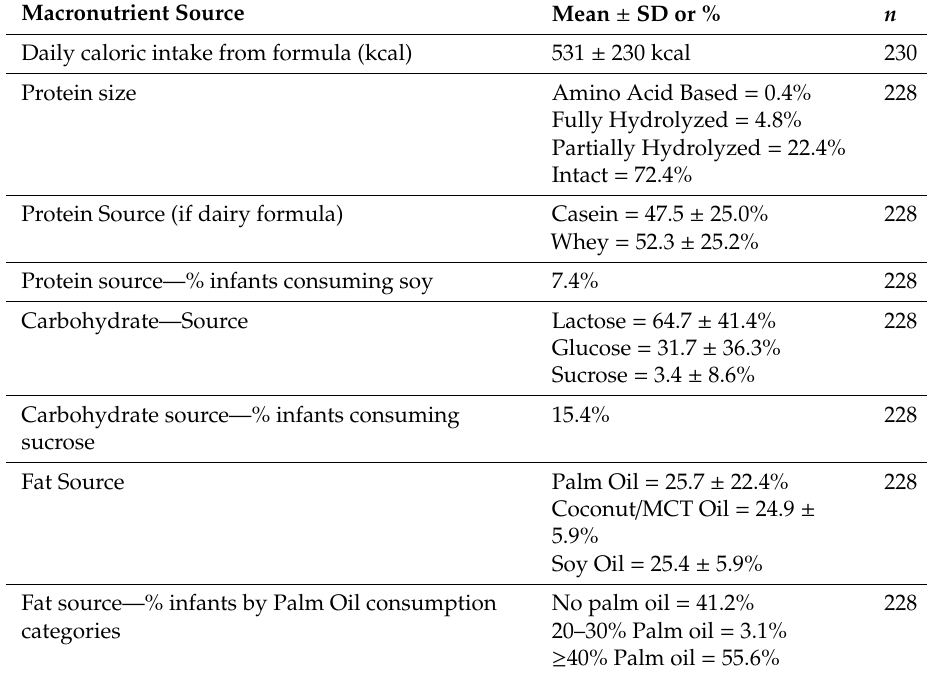
Table 2. Average Infant formula macronutrient sources ( n = 230).